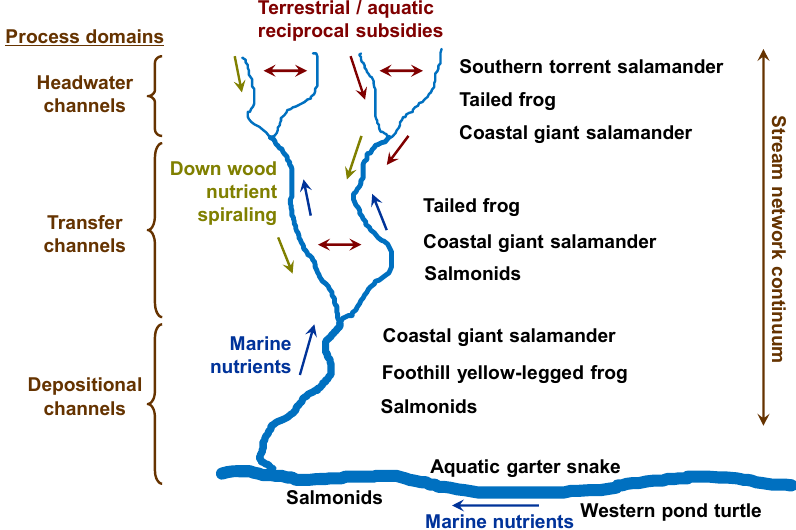
Figure 14. Each process domain (Figure 7) exerts unique hydrogeomorphic influences on the network continuum, creating and modifying specific channel types, each with its own dynamic patch mosaic of habitats. These varying patch mosaics determine the combination of flora and fauna that comprise the biodiversity within a stream network. To illustrate the concept here we have depicted part of the herpetofaunal assemblage based on [53], and identified several important ecological processes (see Figures 1 and 13 for others). A more complete list of ecological elements and processes of stream networks can be found in [45]; Table